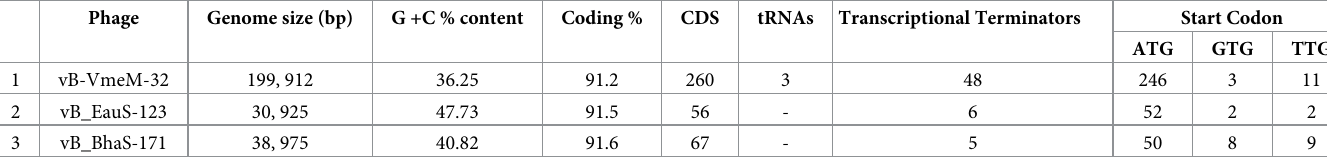
Table 3. General features of genomes vB_VmeM-32, vB_EauS-123 and vB_BhaS-171. A summary of genome characteristics.